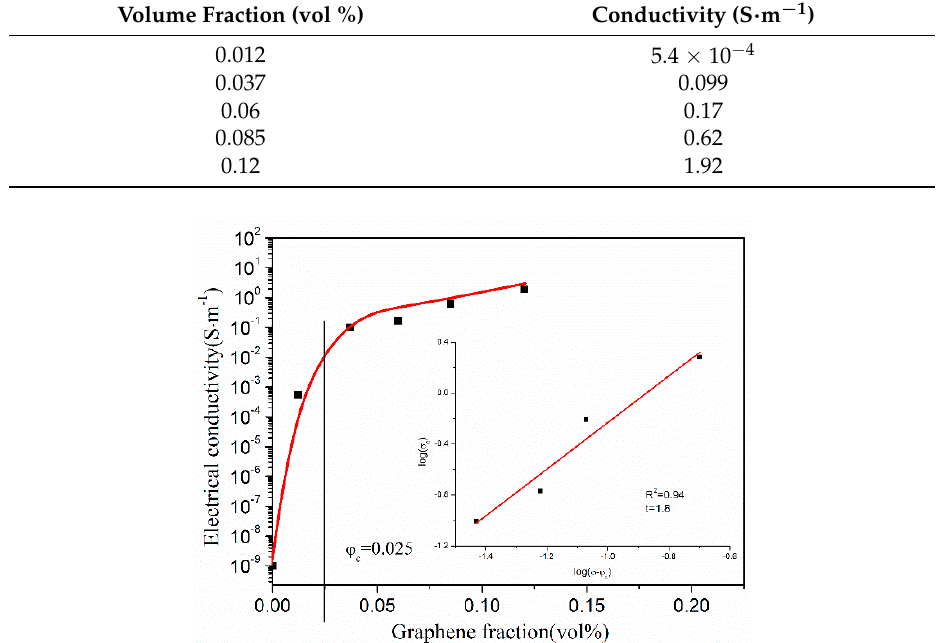
Table 3. The conductivity of the polymer composites filled with different fillers in previous reports.